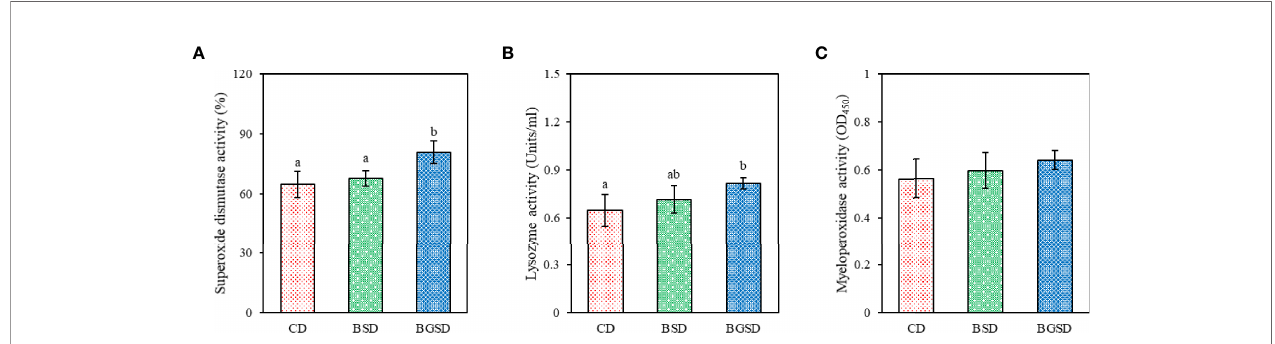
FIGURE 2 | Serum non-speci fi c immune parameters [ (A) , superoxide dismutase; (B) , lysozyme activity; (C) , Myeloperoxidase activity] of red sea bream fed with the experimental diets. The data represent the mean ± standard deviation; different letters indicate statistically signi fi cant differences between groups ( P < 0.05). Control diet, CD: without Bacillus sp. PM8313 or b -glucan, BSD: 1 × 10 8 CFU g − 1 Bacillus sp. PM8313, and BGSD: BSD + 0.1% b -glucan.